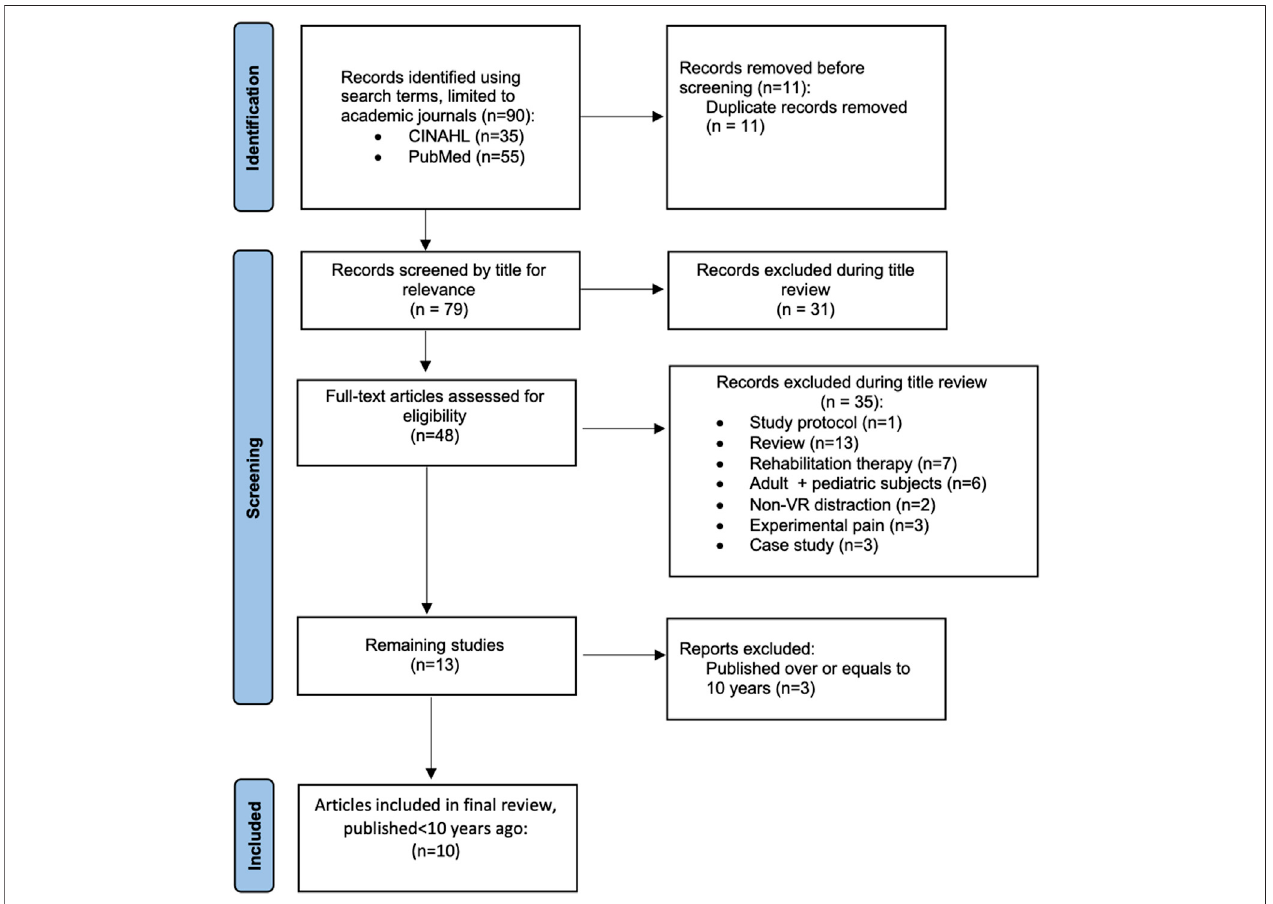
FIGURE 1 | Study selection process. 90 publications in the literature were identi fi ed using the search terms. After the screening and full-text reading, the current review included 10 relevant publications.